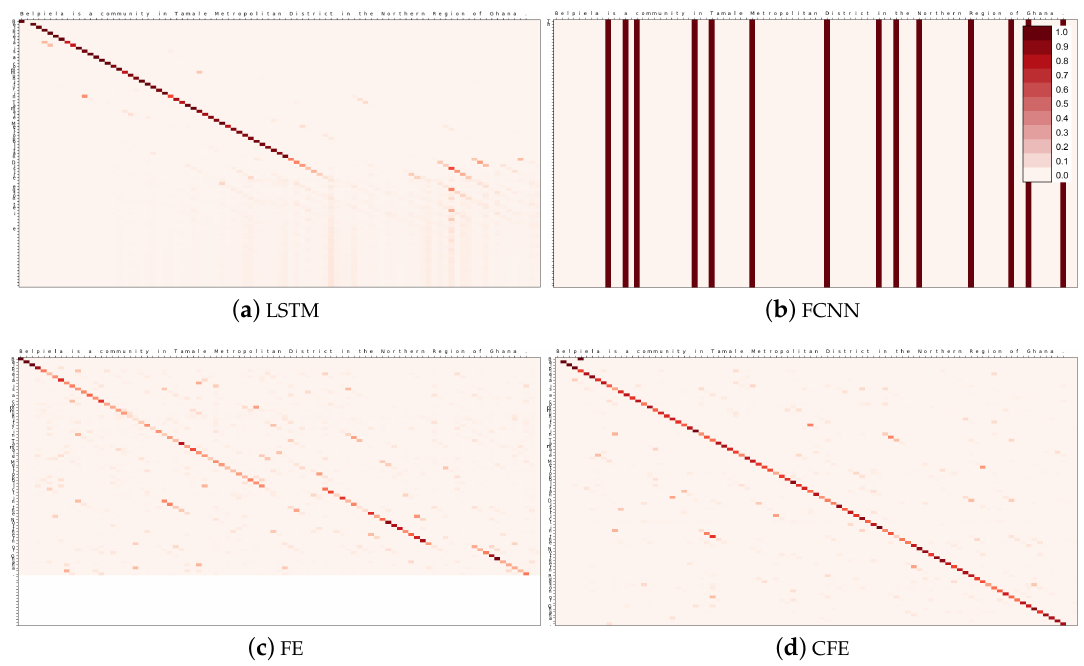
Figure 13. Attention matrices obtained by the four models for the sample selected from E2, shown in Table 10. The input sentence (horizontal axis) is “ Belpiela is a community in Tamale Metropolitan District in the Northern Region of Ghana. ” The values represented are the attention coefficients, α (cid:48) a darker color represents a larger